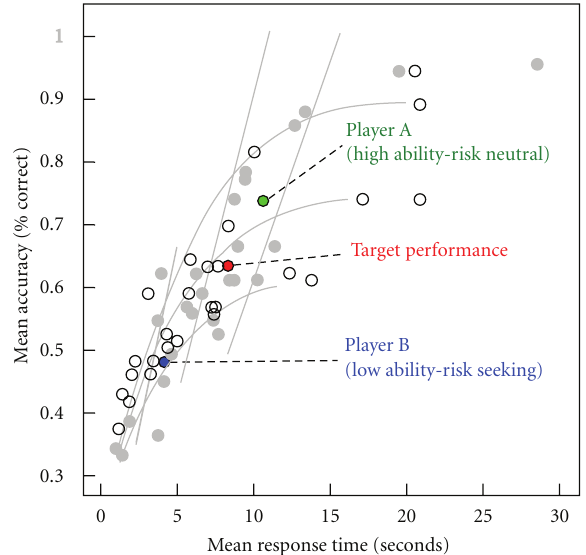
Figure 7: Player ability and risk profile can be measured dynam- ically to identify particle filter size ( P ) and decision threshold ( c ) parameters. These parameters can be used to adjust the degree of similarity between distracters and target and move di ff erent types of players to the same target